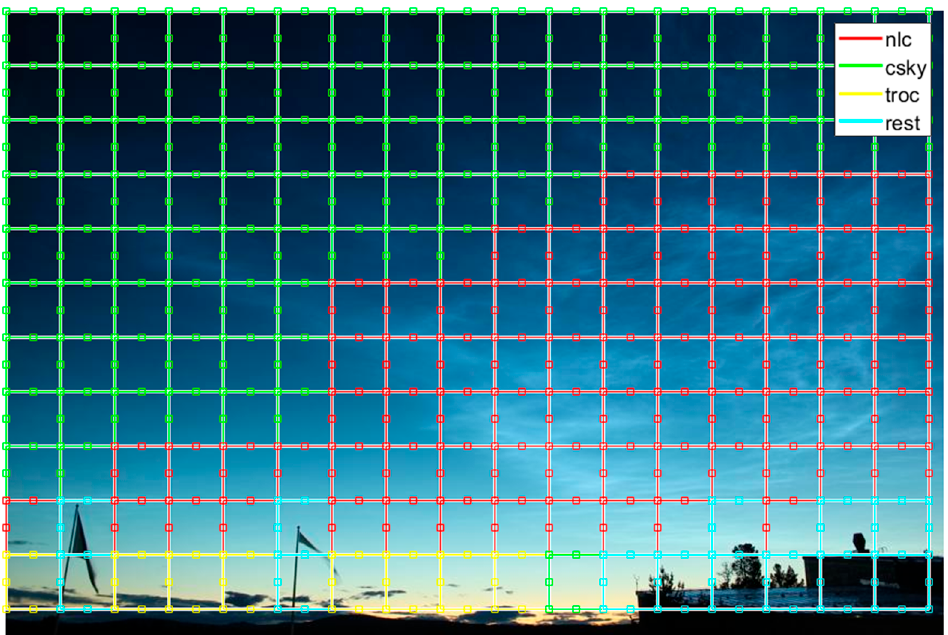
Remote Sens. 2019 , 11 , x FOR PEER REVIEW Figure 11. The majority of the noctilucent cloud activity is correctly predicted by the CNN algorithm.